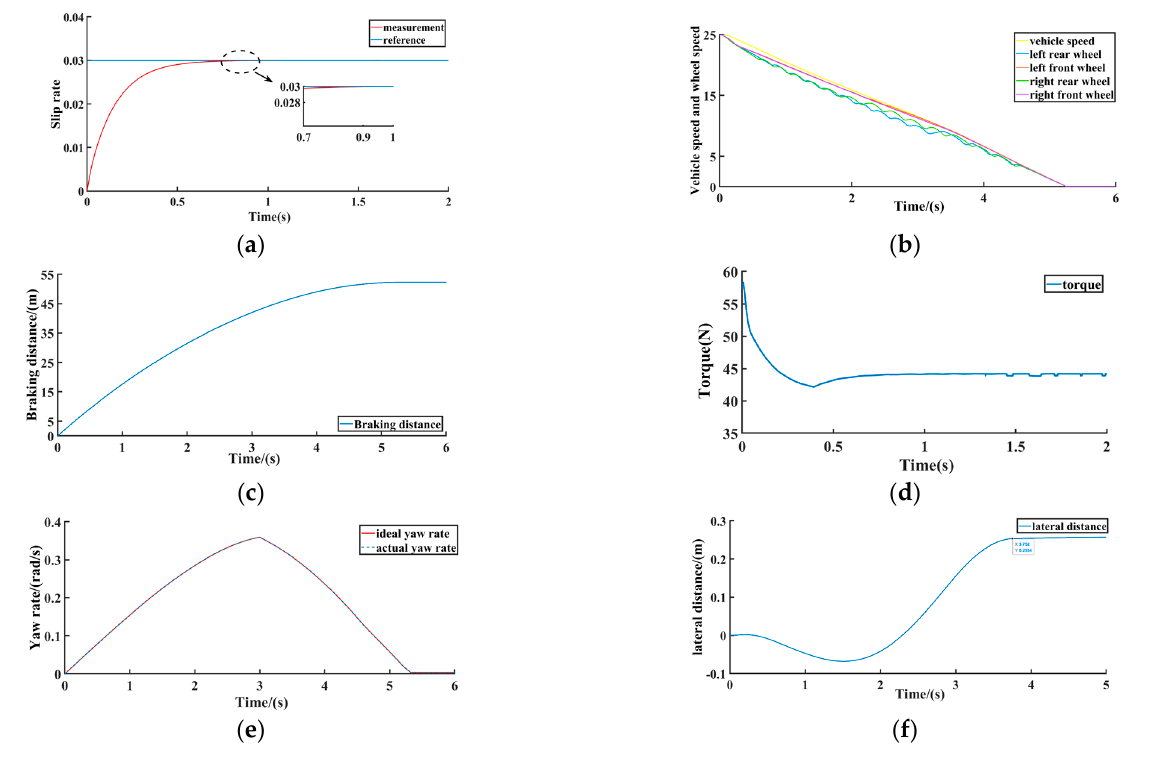
Figure 8. Vehicle driving on an icy and snowy road under extreme conditions. ( a ) Slip rate. ( b ) Vehicle speed and wheel speed. ( c ) Braking distance. ( d ) Braking torque. ( e ) Ideal yaw rate and actual yaw rate. ( f ) Vehicle lateral displacement.